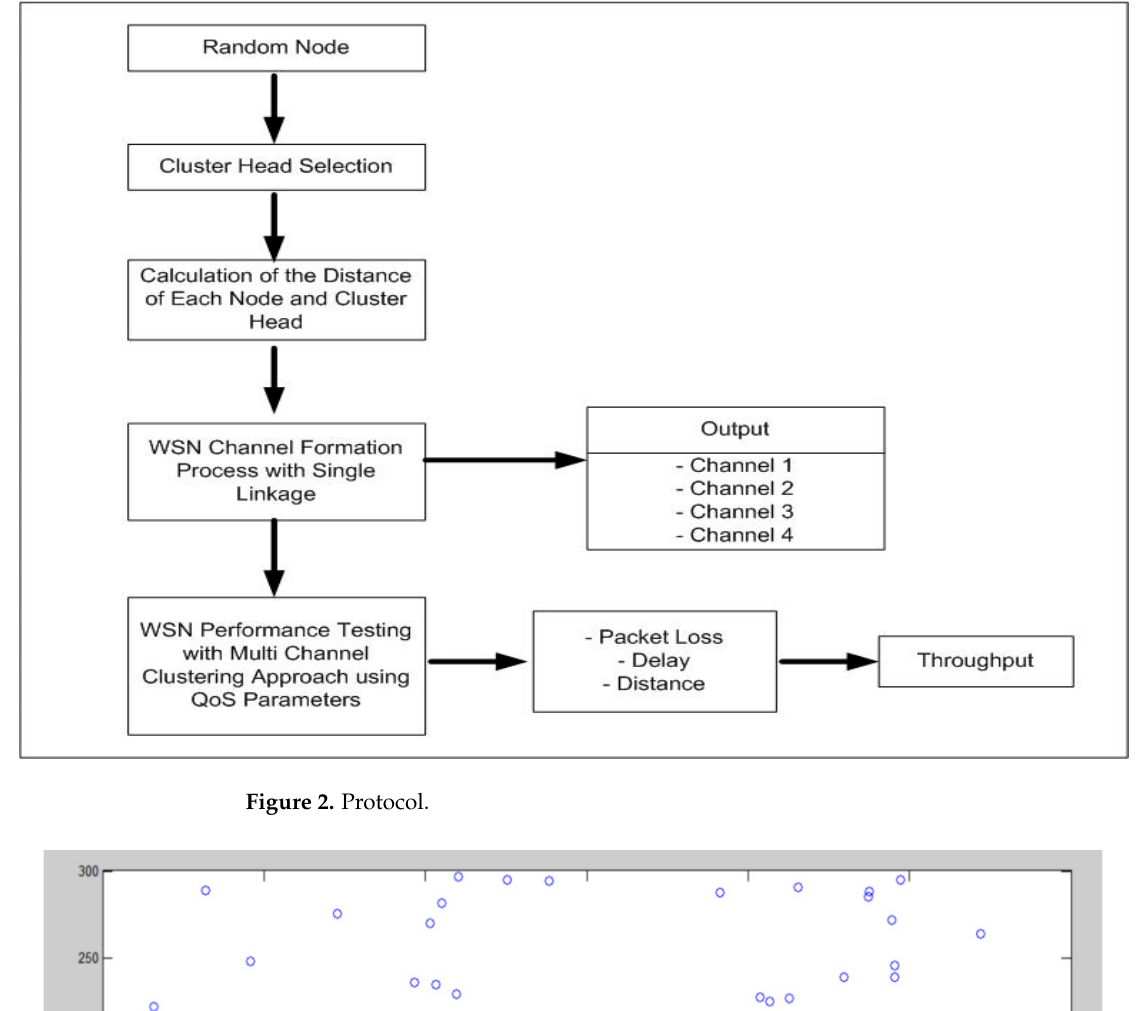
Figure 2. Protocol.